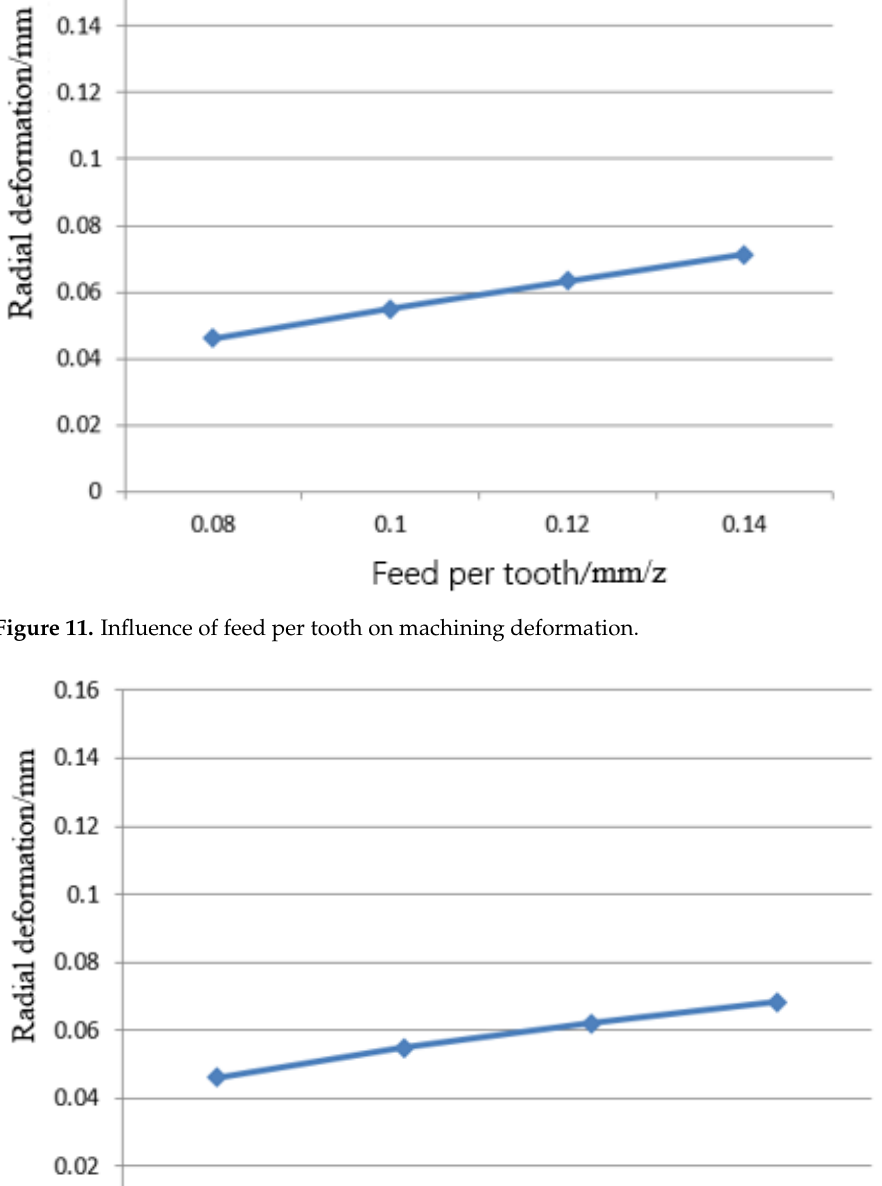
Figure 11. Influence of feed per tooth on machining deformation.